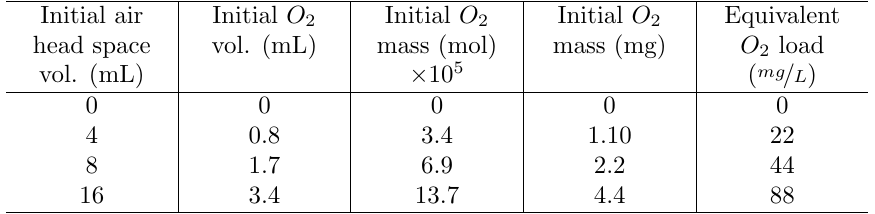
Table 2: Oxygen loading conditions tested in experiments and in simulations.